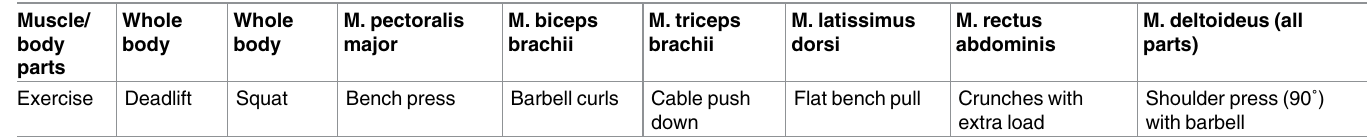
Table 1. Type of exerciseswith muscles